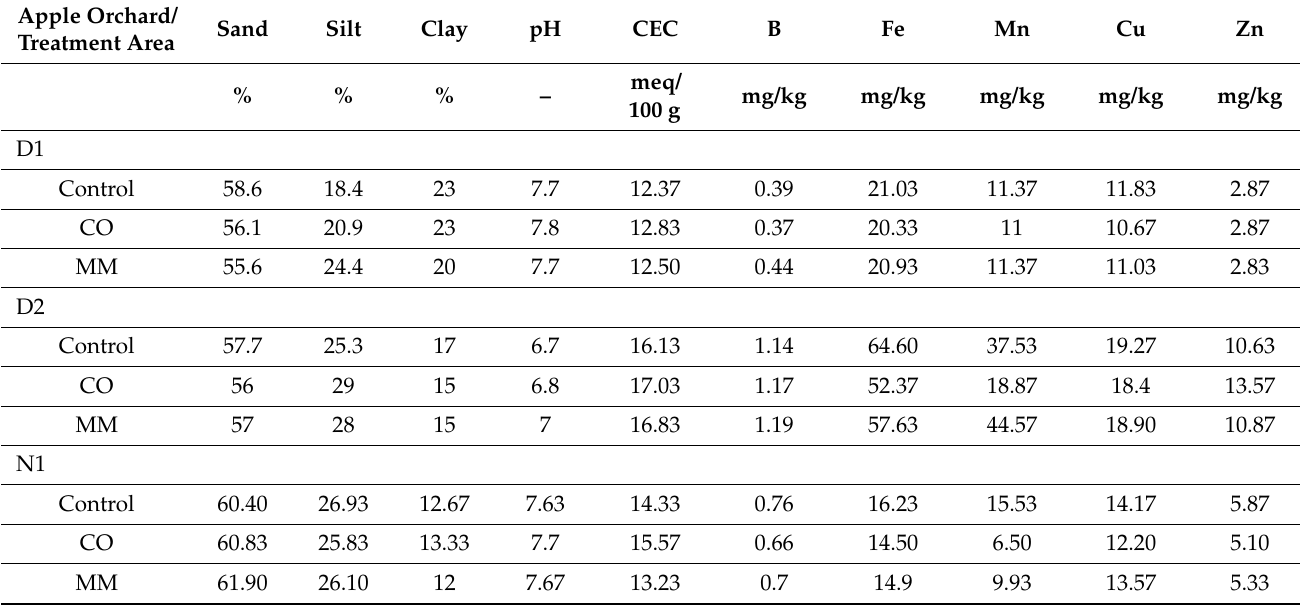
Table 2. Soil preliminary characterization. Micronutrient, pH, CEC, and texture data of each treatment before amending (T0); comparing soil from the area before amending with compost from digestate (CO), soil from the area before amending with matured manure (MM), and soil from the area without amendments application